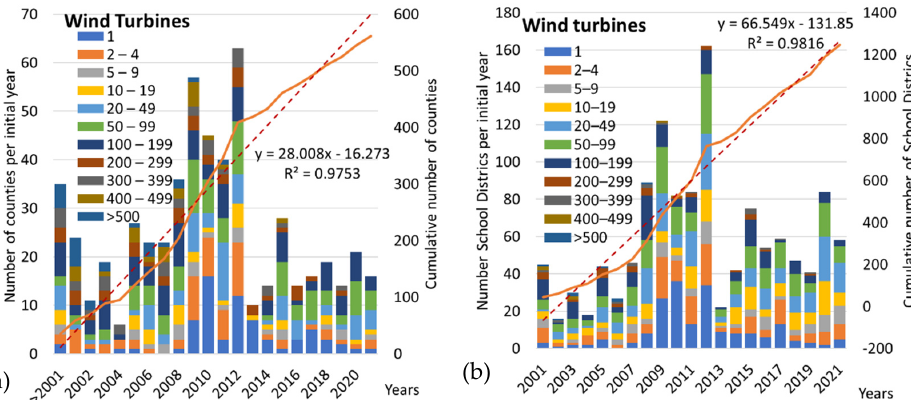
Figure 6. Wind turbine initial installation year categorized by the total number of wind turbines placed inside as indicated with ( a ) individual counties ( b ) School Districts. Data are characterized by applying lineal regression, with the chart displaying the equation for the regression model with x as the independent variable and y as the dependent variable. R 2 is the coefficient of determination indicating a very good fitness for a linear regression model.